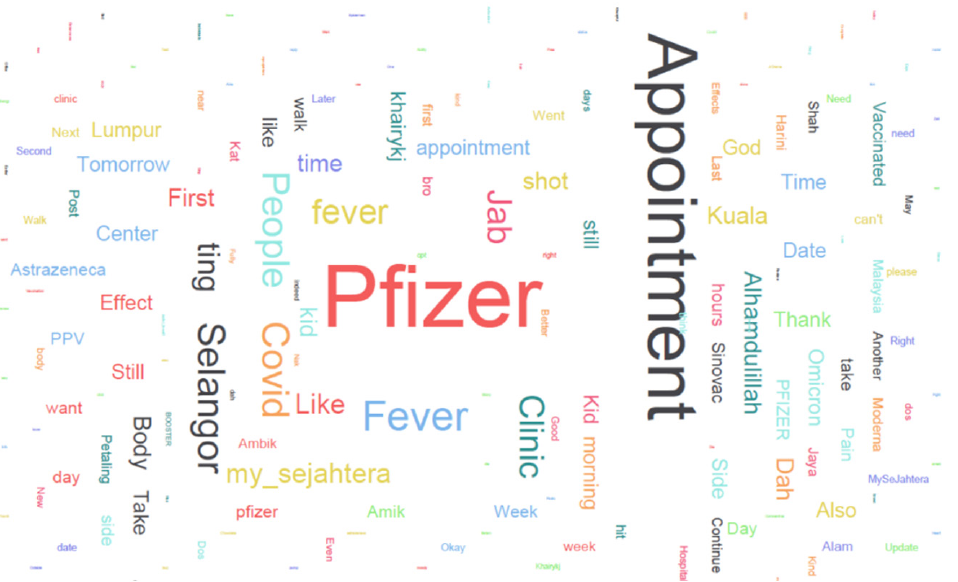
Figure 6. Word cloud.